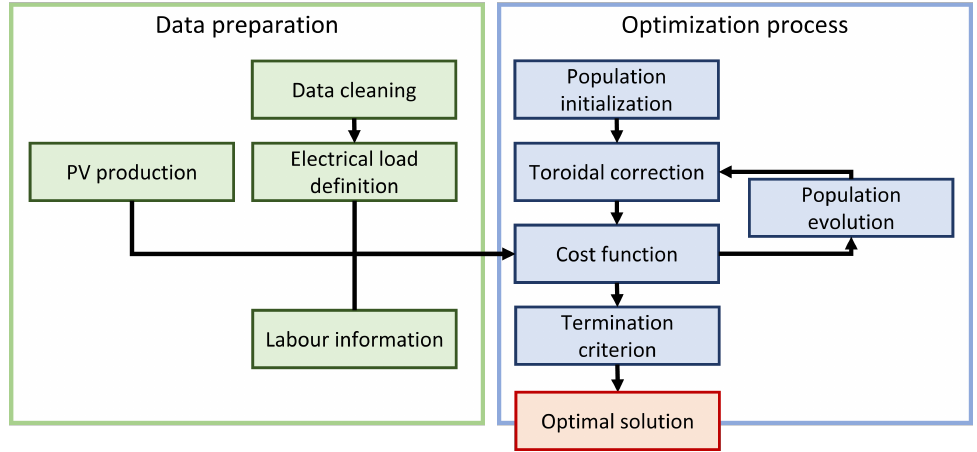
Figure 1. Flowchart of the proposed